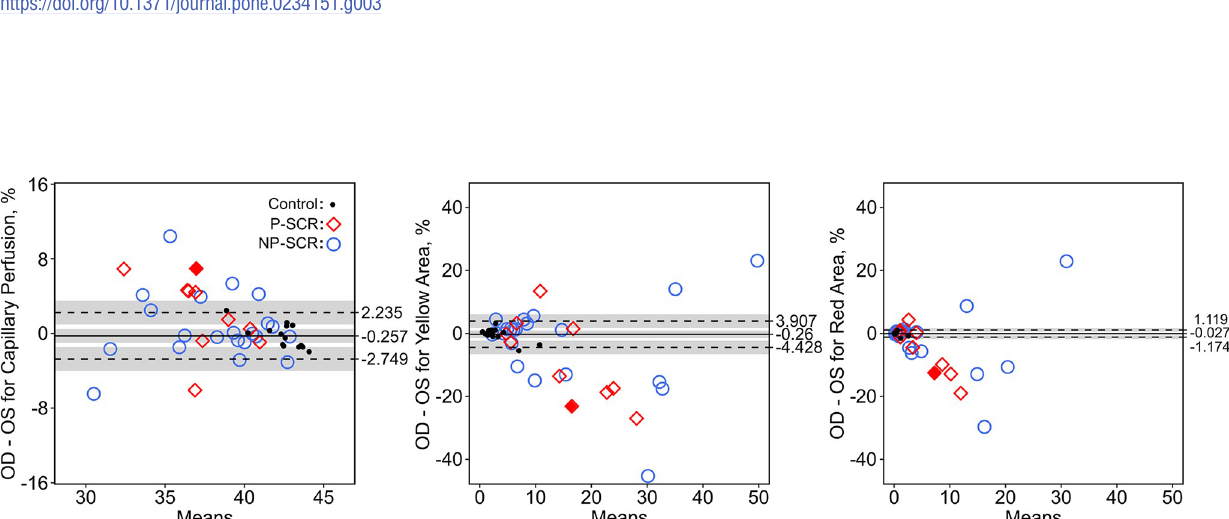
Fig 4. Interocular difference of parafoveal capillary density measurements following Bland-Altman analysis. The mean bias (displayed as the solid line) and LOAs (of 2.5% and 97.5% shown in dashed lines) were computed based on unaffected controls, and interocular asymmetry was defined as a value outside these LOAs. The 95% confidence intervals for the mean bias, upper LOA, and lower LOA are shown in gray. Representative subject labeled with a solid red diamond is displayed in Fig 5.